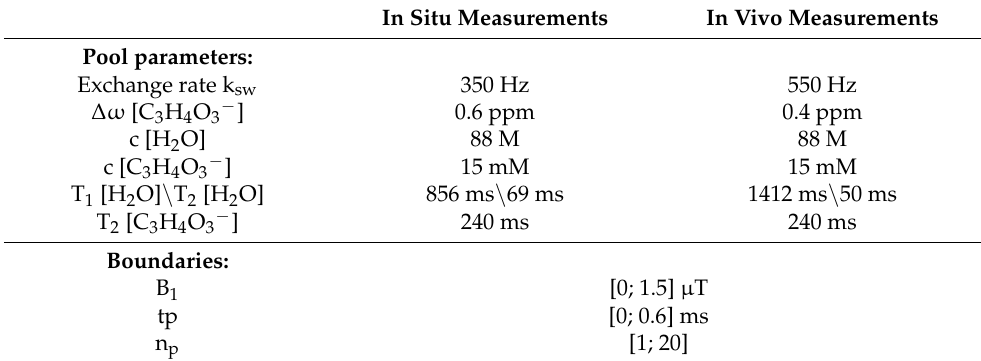
Table 2. Parameter and boundary settings for the optimization of the pre-saturation module. In Situ Measurements In Vivo